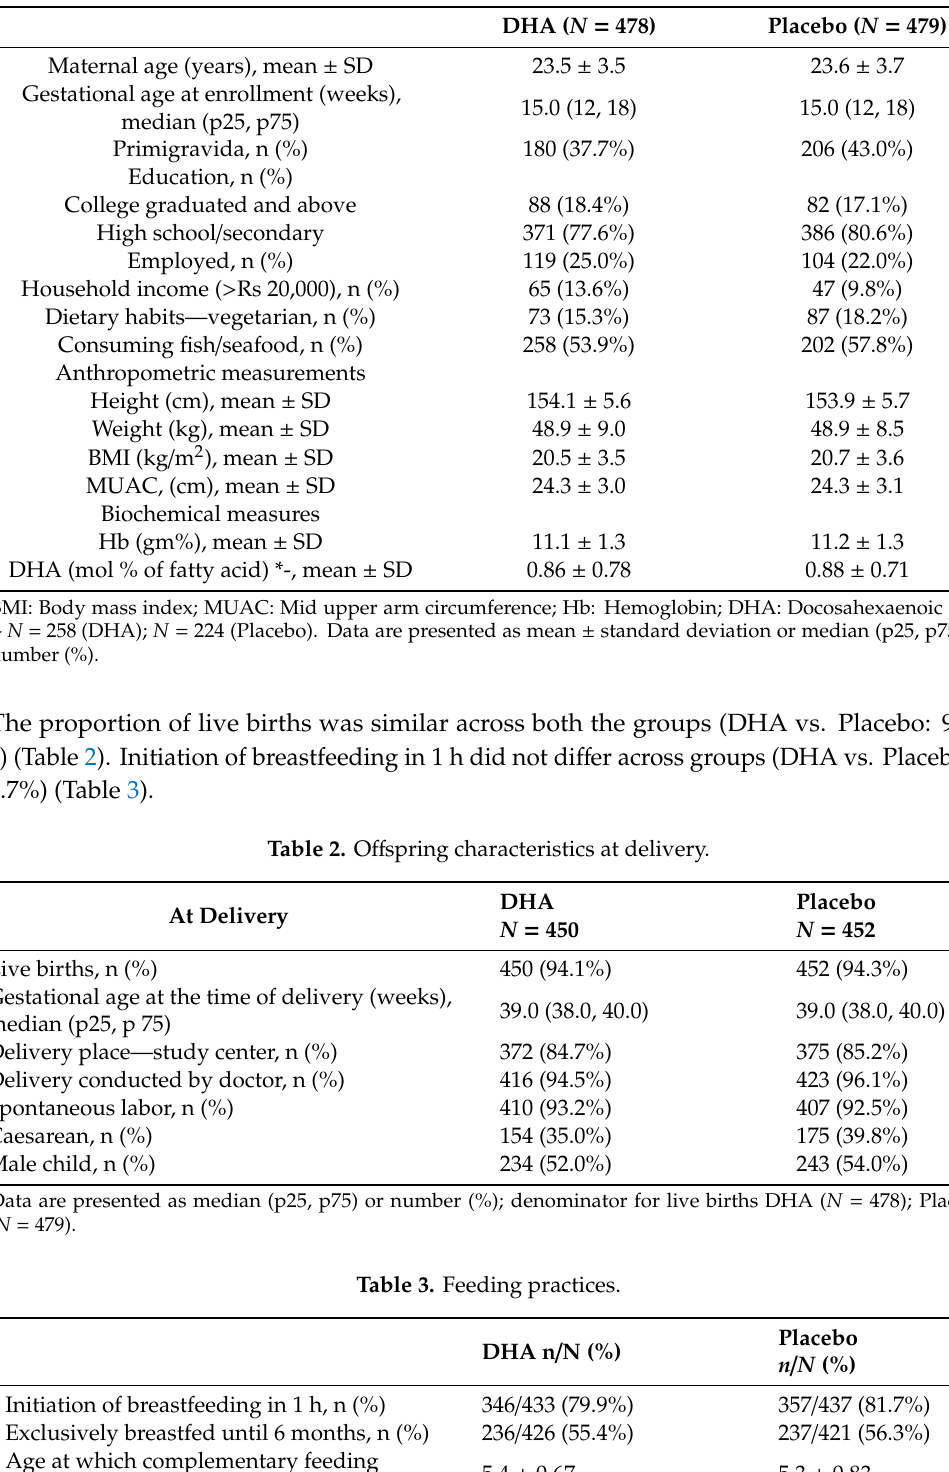
Table 1. Baseline Characteristics.